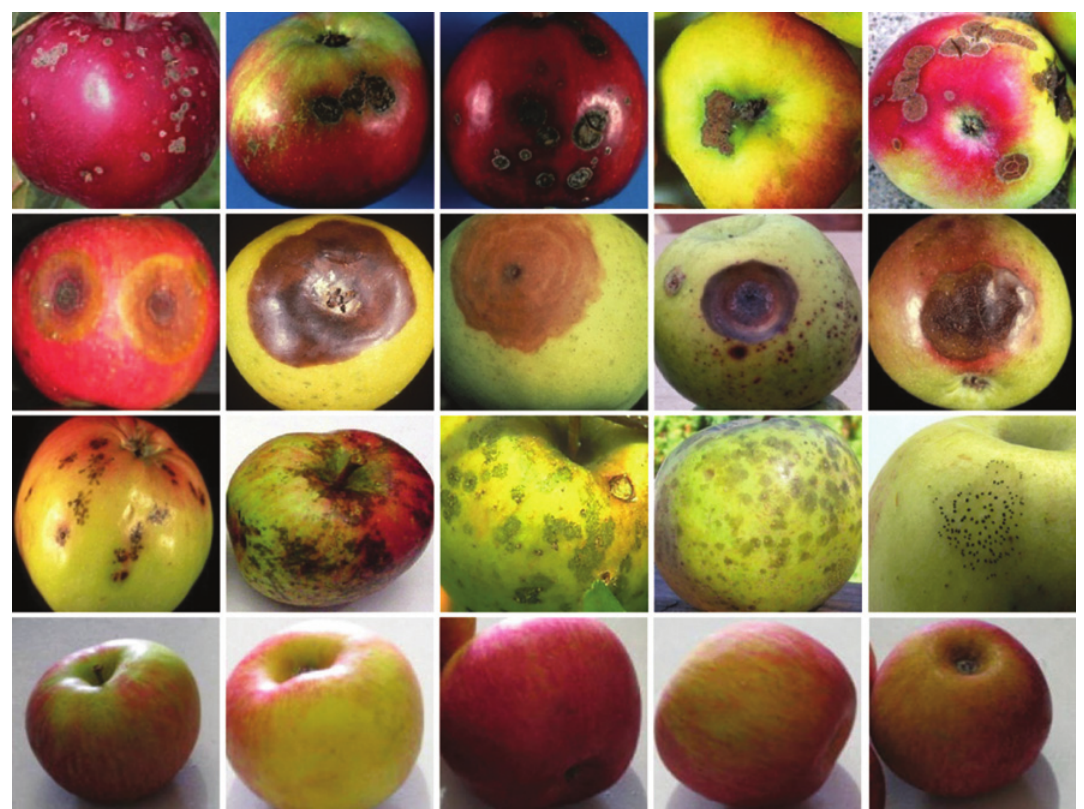
Figure 5. Some Images of the Apples Infected with Scab, Rot, Blotch, and Normal Apples of the Dataset [19].